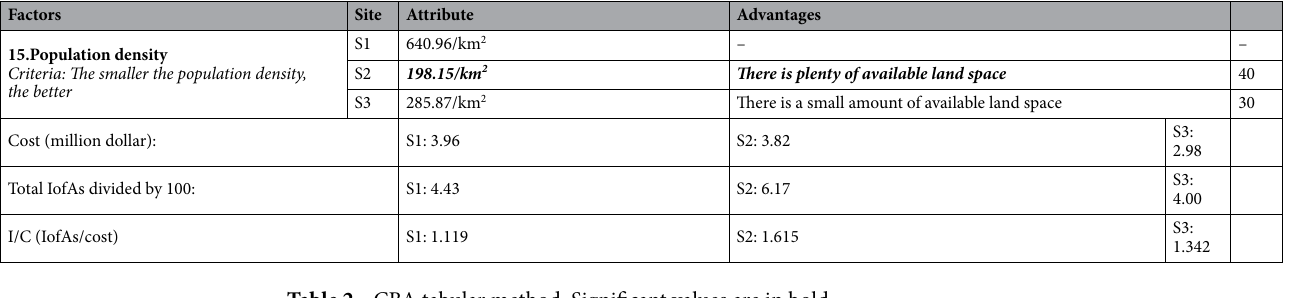
Table 2. CBA tabular method. Significant values are in bold.